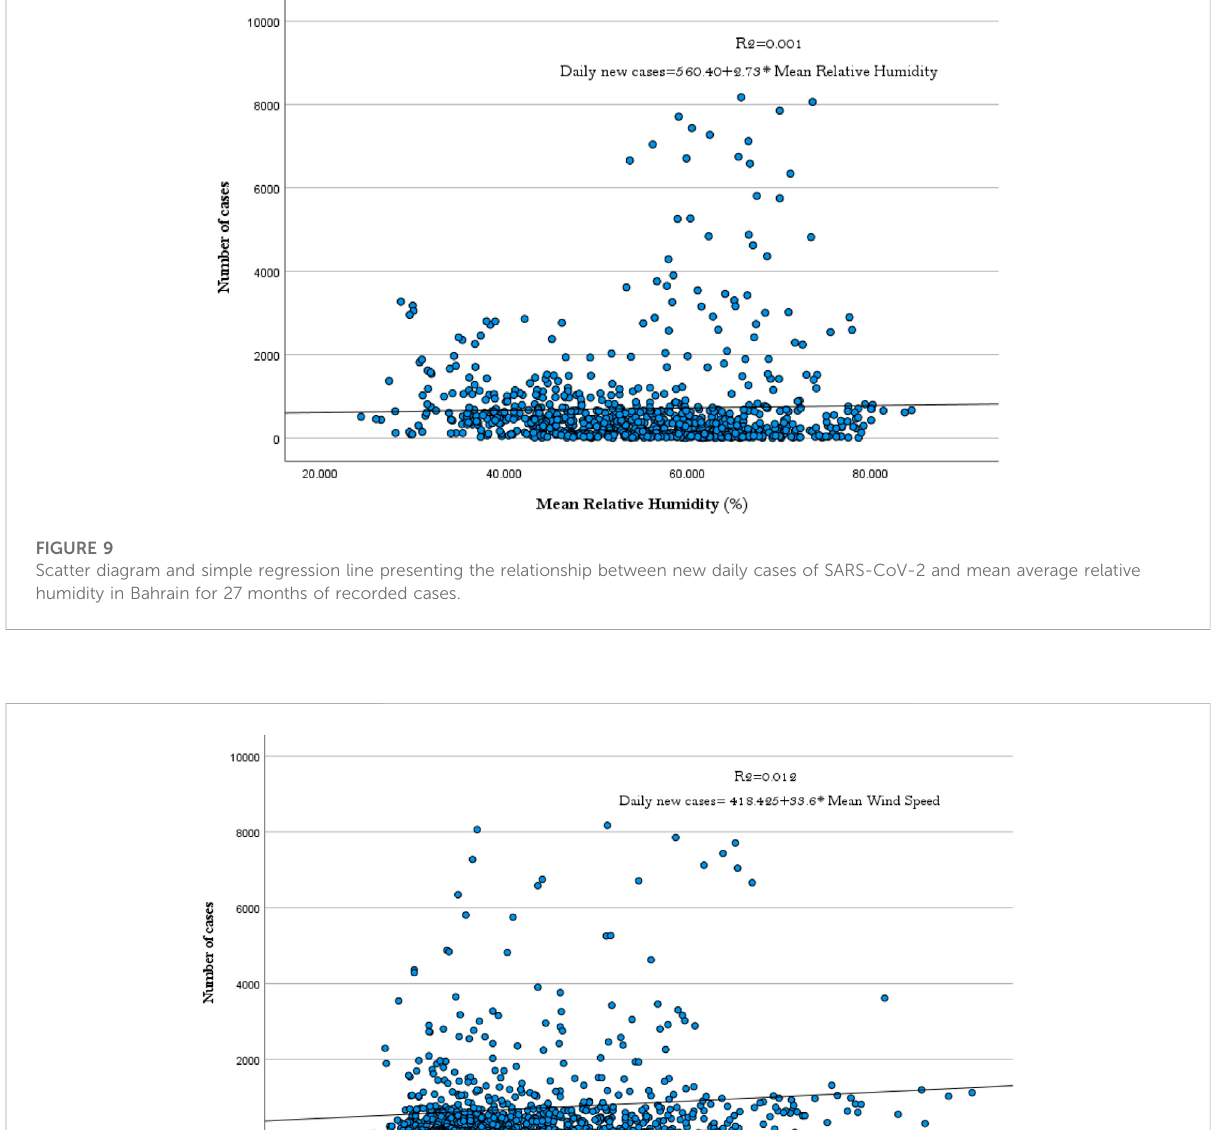
Frontiers in Built